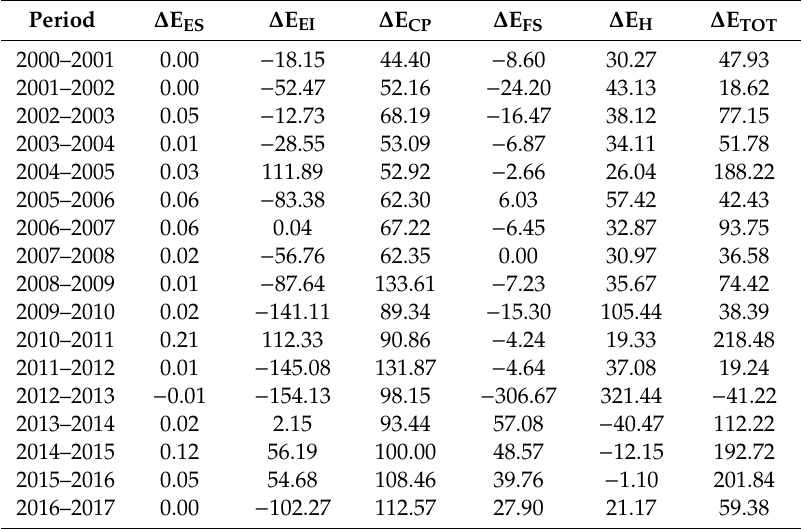
Table A3. Detailed decomposition results of REC in urban Guangdong, (Ttce).